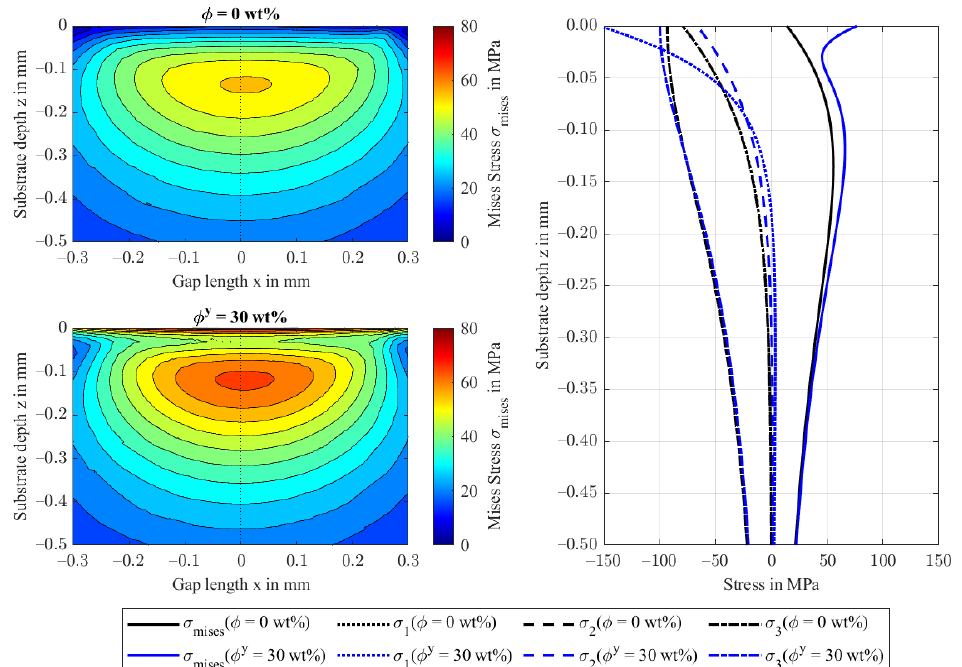
Figure 9. von Mises stresses in the xz-plane at y = 0 for 𝜙 𝑦 = 0 and 30 wt.% in the y-direction ( left ) and the respective principal stresses of the FRP substrate in depth direction z ( right ).